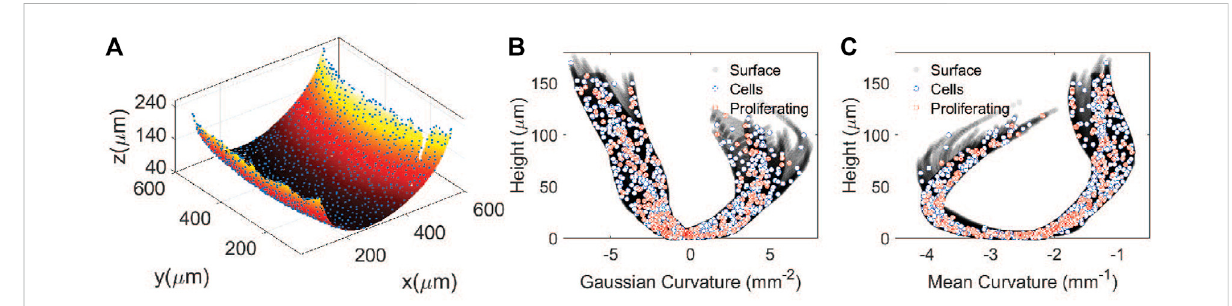
FIGURE 6 Identi fi cation of cells with substrate curvature. (A) Projection of cell centroids onto the recontructed hydrogel surface. (B) Gaussian curvature versus height for each cell. (C) Mean curvature versus height for each cell. The fi lled circles are points on the surface. The open circles represent all the cells and the crosses are proliferating